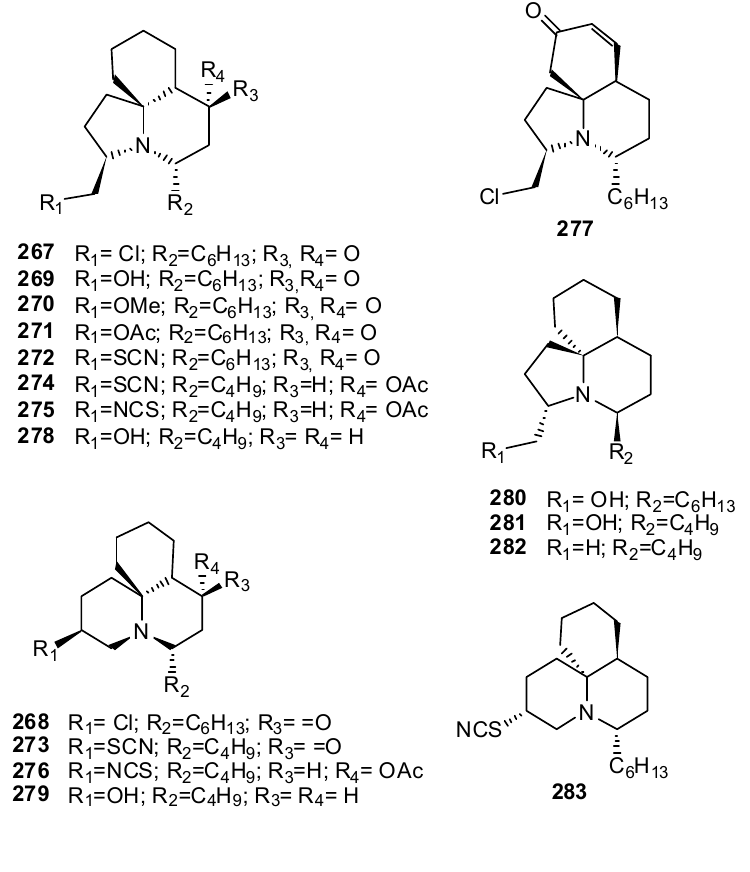
Figure 29. Structures of tricyclic lysine-derived alkaloids from